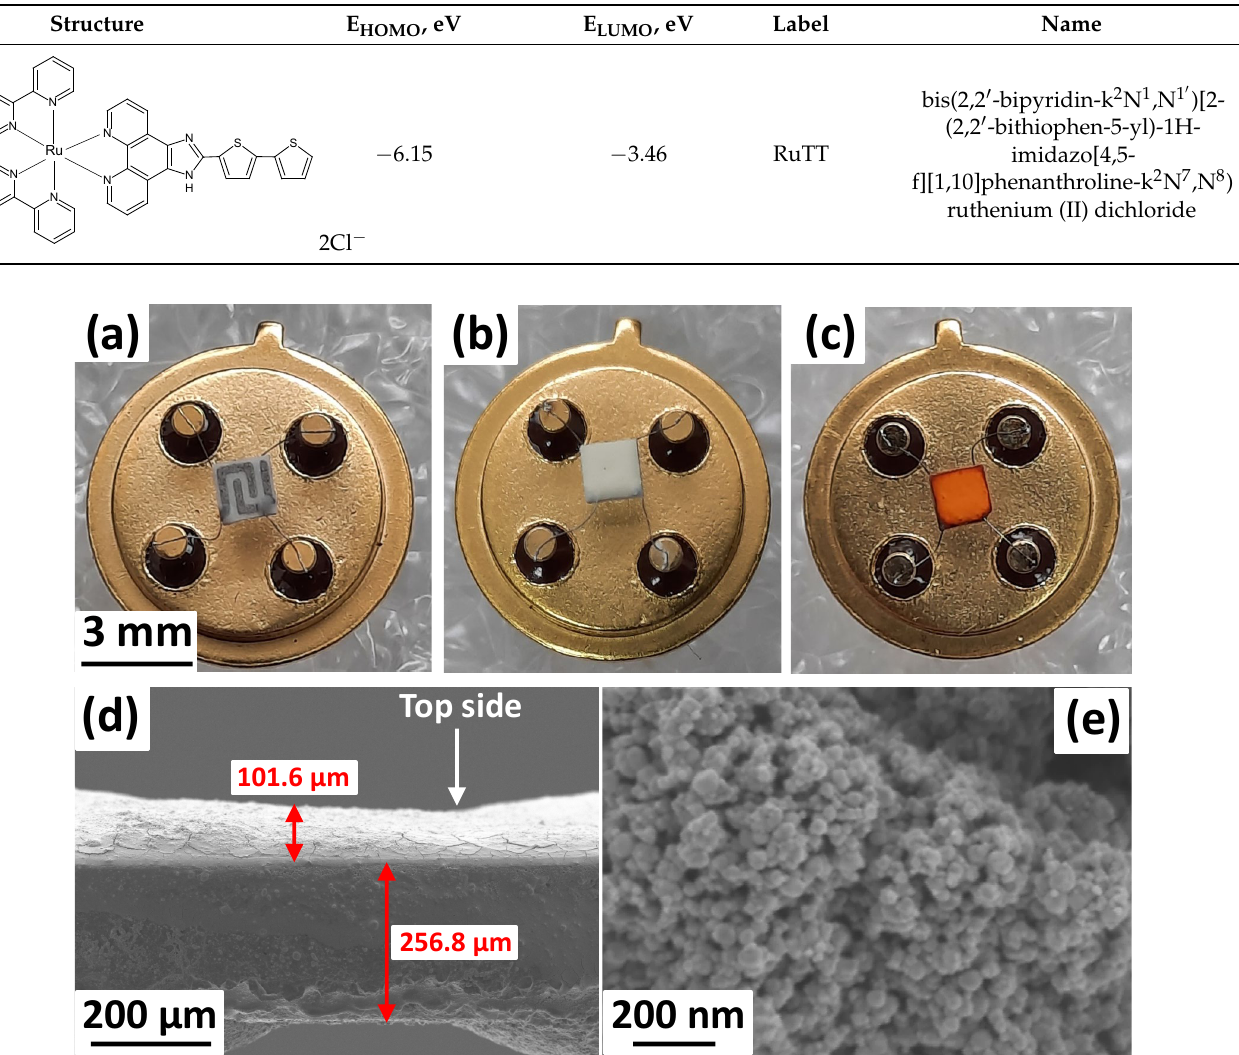
Table 1. Structural formula, the energies of HOMO and LUMO and the label of the Ru(II) heteroleptic complex.